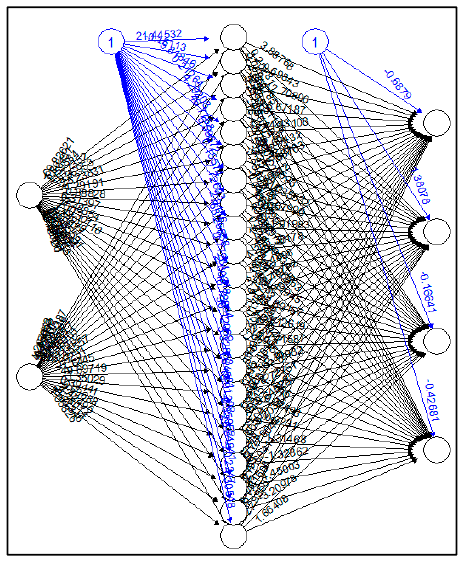
Figure 10. Illustration of the ANN obtained and used in this experiment.